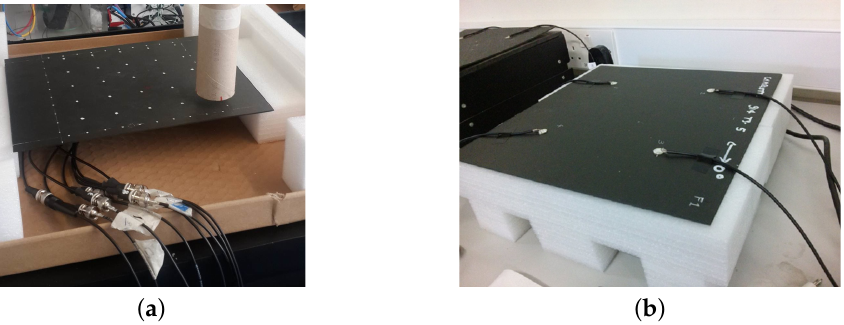
Figure 1. Composite panel subjected to the experimental tests. Top view ( a ); and bottom view with sensors ( b